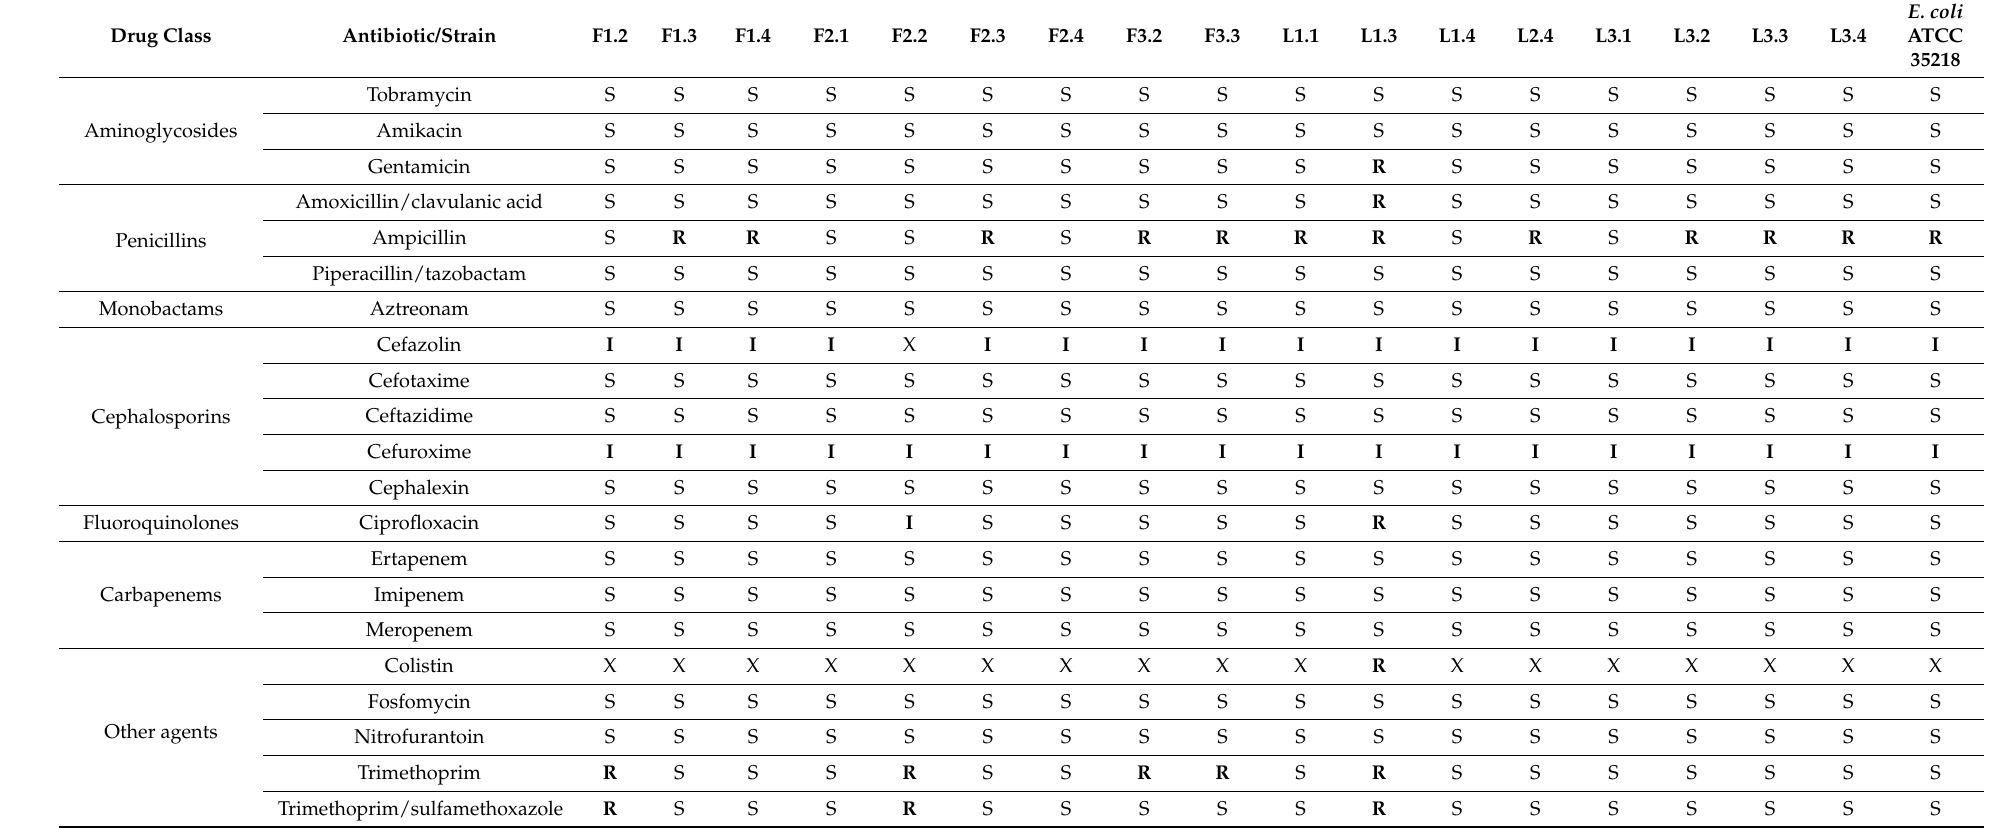
Table 2. Antibiotic resistances of the isolates identified as E. coli by BD Phoenix